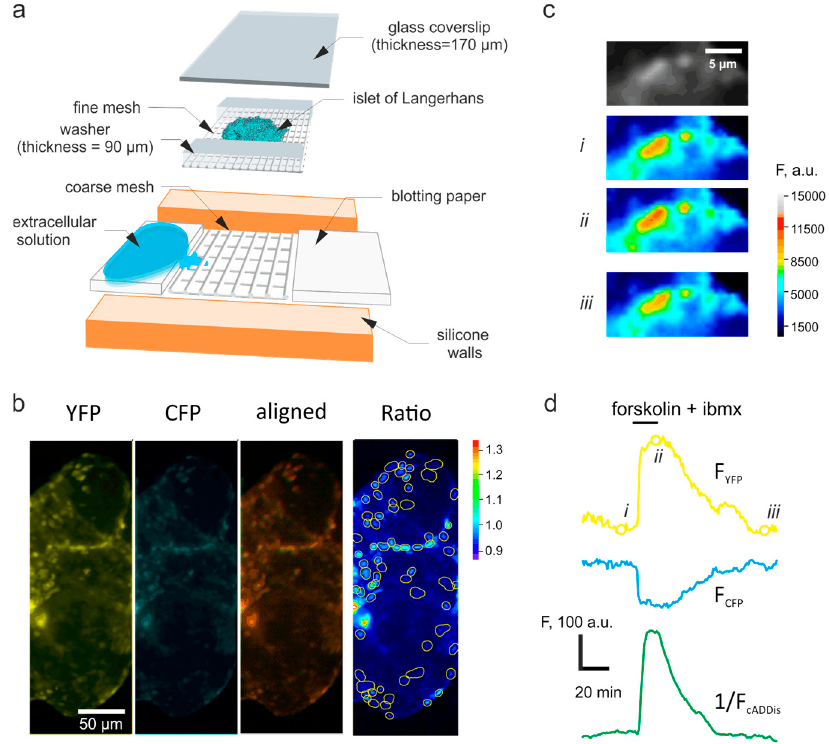
Figure 1. Imaging set-up, sensor expression and the FRET channels. ( a ) Schematic of the imaging chamber. ( b ) Expression of the recombinant proteins kinase A (PKA) sensor, AKAR3, in islets of Langerhans. Raw YFP, CFP channel fluorescence, imaged using epifluorescence microscopy, alignment of YFP and CFP channels, and the YFP/CFP ratio, as indicated. The individual cells (regions of interest) detected as intensity maxima, are outlined in yellow on the ratio image. ( c , d ) Representative changes in the raw fluorescence intensity of the YFP channel ( c ) corresponding to the three indicated time-points of the raw kinetics traces ( d ) of the YFP (top, yellow), CFP (middle cyan) channels recorded pseudosimultaneously with the fluorescence of Green Downward cADDis (bottom, green).